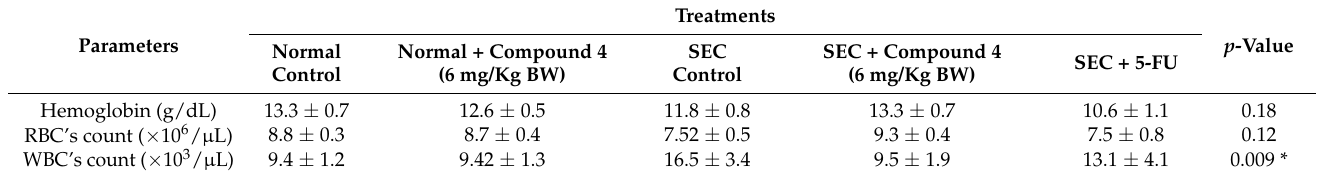
Table 2. Effects of compound 4 and 5-FU treatments on the hematological parameters of SEC-bear- ing mice.